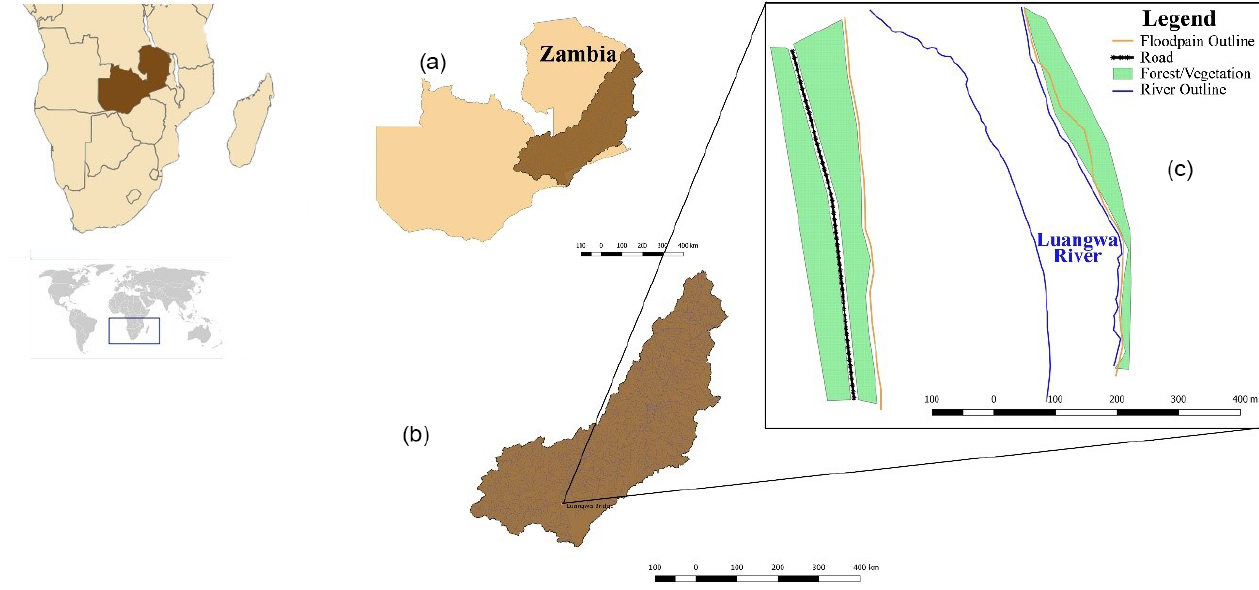
Figure 1. Study area map: (a) Zambia, (b) Luangwa River, (c) mapped area.